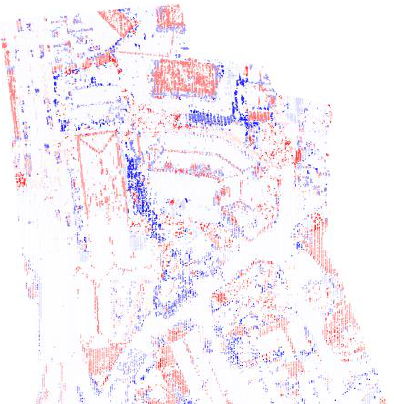
Figure 7. Top and bottom are misclassified points in RF and TF respectively: Middle is the final product from